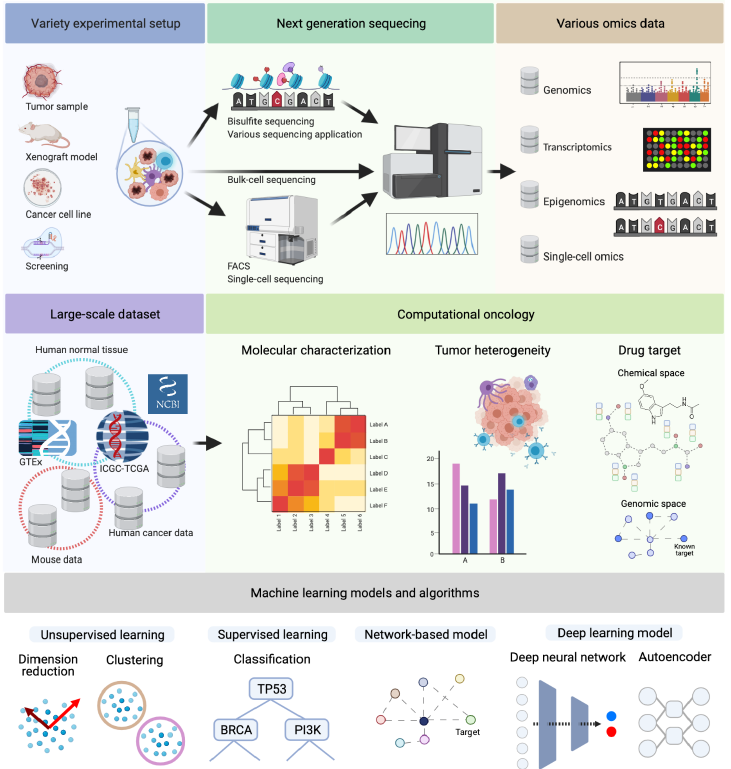
Figure 1. Next-generation sequencing data can originate from various experimental and technological conditions. Depending on the purpose of the experiment, one or more of the depicted omics types (Genomics, Transcriptomics, Epigenomics, or Single-Cell Omics) are analyzed. These approaches led to an accumulation of large-scale NGS datasets to solve various challenges of cancer research, molecular characterization, tumor heterogeneity, and drug target discovery. For instance, The Cancer Genome Atlas (TCGA) dataset contains multi-omics data from ten-thousands of patients. This dataset facilitates a variety of cancer researches for decades. Additionally, there are also independent tumor datasets, and, frequently, they are analyzed and compared with the TCGA dataset. As the large scale of omics data accumulated, various machine learning techniques are applied, e.g., graph algorithms and deep neural networks, for dimensionality reduction, clustering, or classification. (Created with